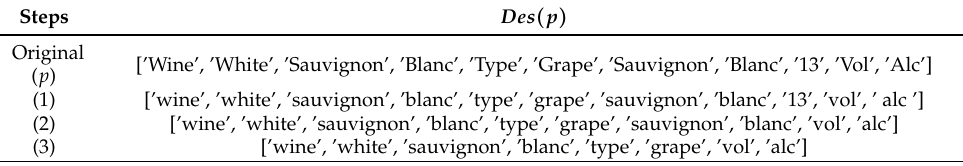
Table 17. Examples of product _ words for every p .